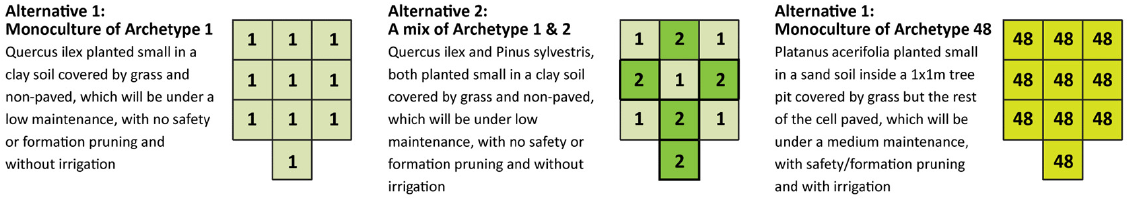
Figure 14. Characteristics of three hypothetical alternatives for a small urban forest of 0.1 Ha.